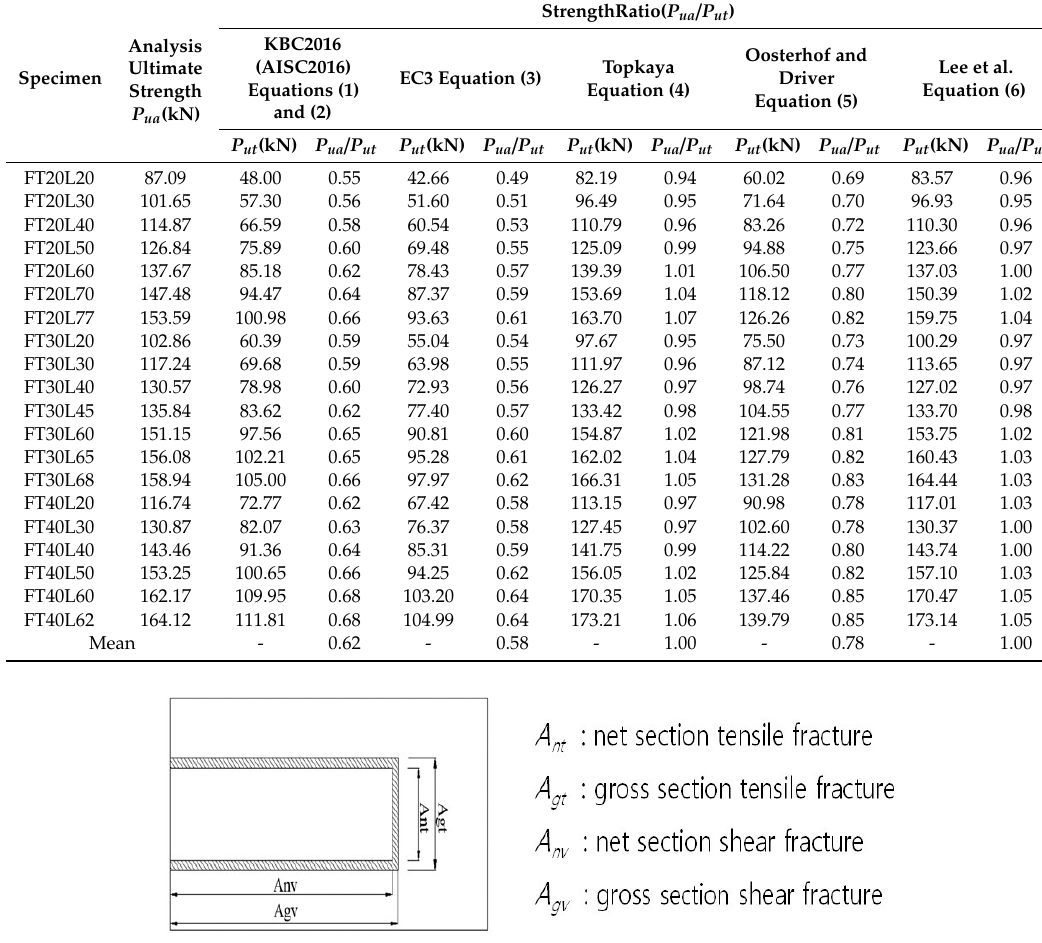
Figure 9. Typical block shear fracture path in welded connection. Table 5. Strength comparison of analysis result and design prediction.